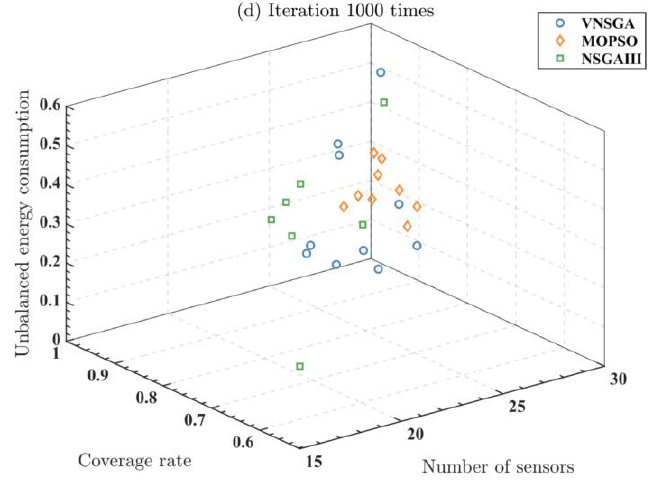
Figure 9. Pareto Optimal solutions for three algorithms: ( a ) Iteration 250 times; ( b ) Iteration 500 times; ( c ) Iteration 750 times; ( d ) Iteration 1000 times.